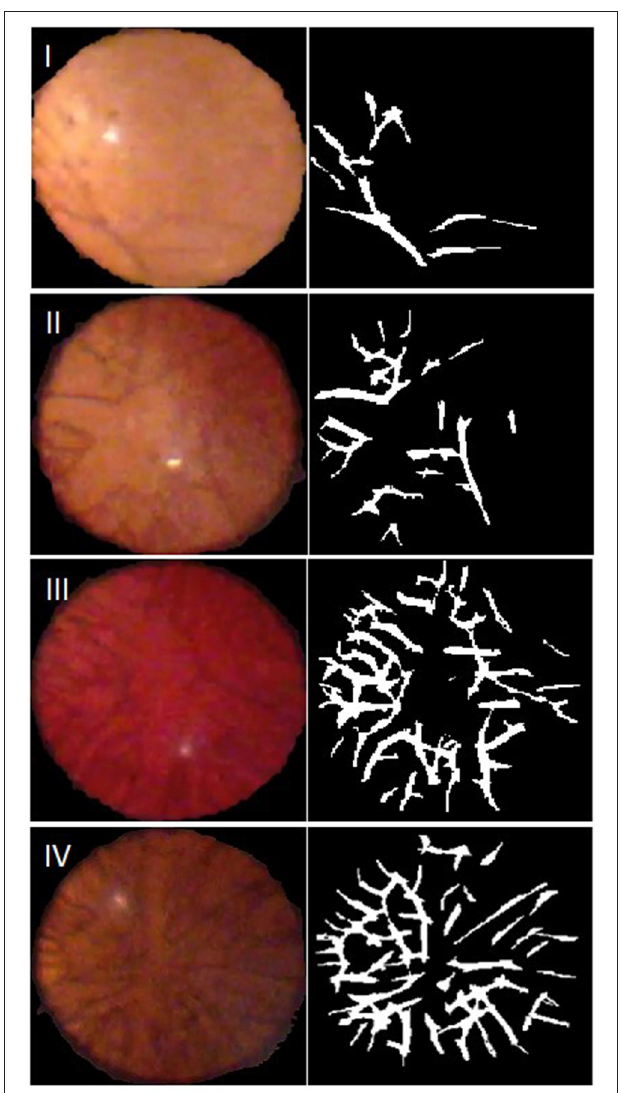
FIGURE 1 | Representative video stills, with Hittner Grading, and their generated binary forms. Grade I: 33–34 weeks gestation; Grade II: 31–32 weeks gestation; Grade III: 29–30 weeks gestation; Grade IV: 27–28 weeks gestation.